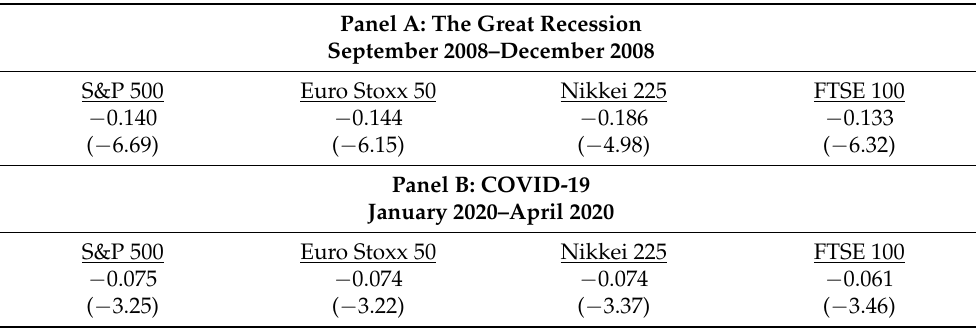
Table 7. Average Slope of the Term Structure of the Expected Market Risk